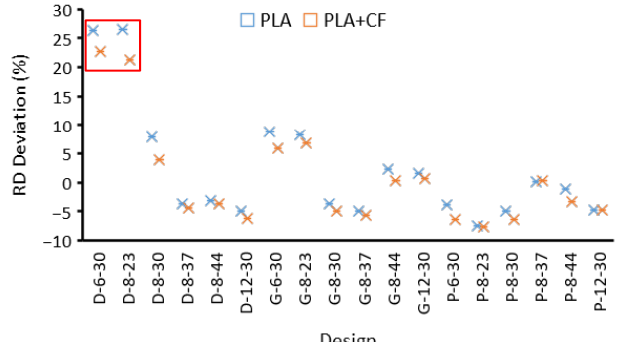
Figure 5. Deviation of the actual RD from the corresponding RD design of the designed lattice structures listed in Table 3. The red box highlights the extreme deviations of the actual RDs from the corresponding CAD designs.